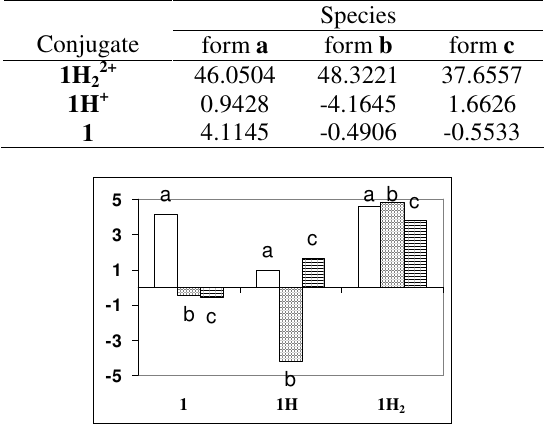
Figure 2. Heats of formation (kJ mol -1 ) of the 3 most stable acid-conjugates of 1 (Energy of 1H 22+ is reduced ten times for